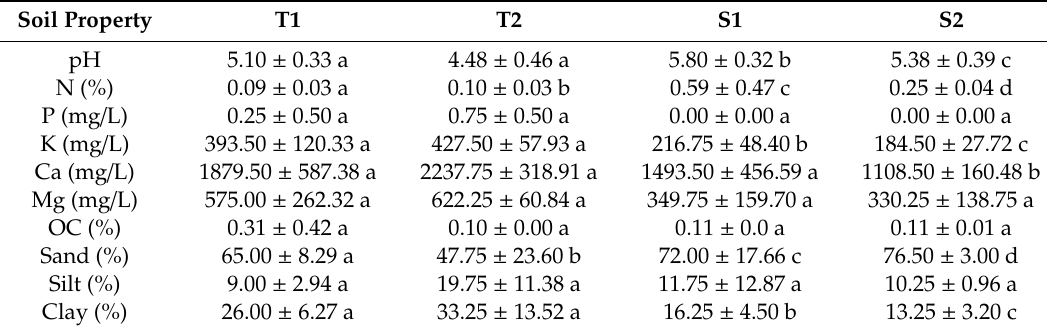
Table 1. Soil properties in termite mound soils and surrounding